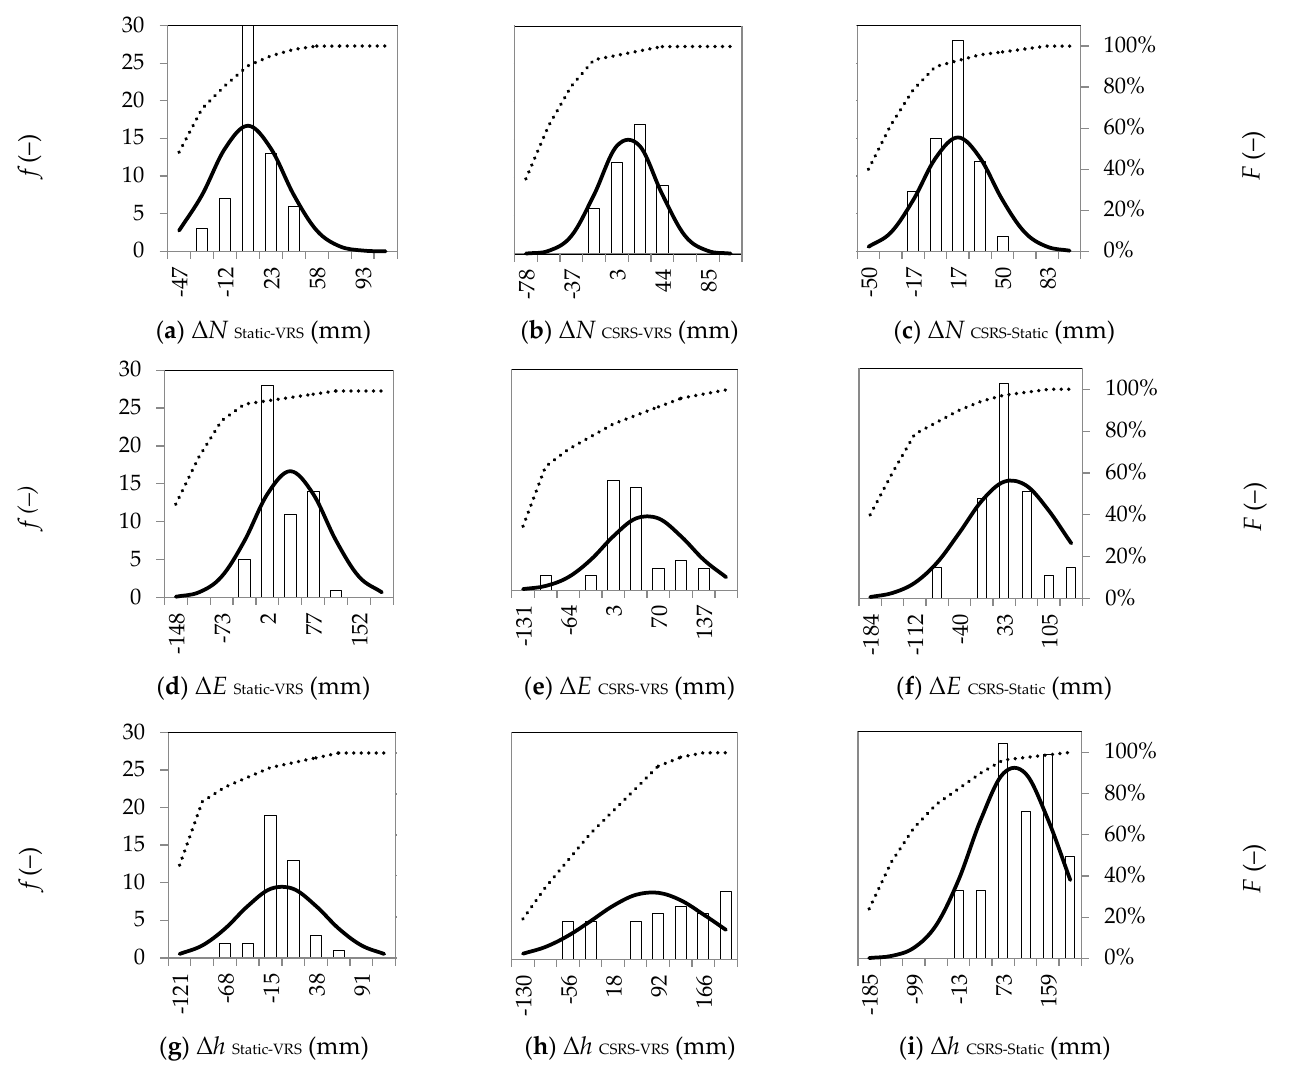
Figure 8. Empirical distribution frequency after extreme values removal (empty bars), best fitting normal distribution (black lines) and cumulative frequency of the empirical frequency before removing the extreme values (dashed line). Δ N, Δ E and Δ h differences (mm) are represented in the upper, central and lower graphs, respectively. Static vs. VRS, CSRS vs. VRS and CSRS vs. Static differences are represented in the left, central and right graphs, respectively, the minimum and maximum x -axis values change for the different pairs according to the corresponding range of variability: ( a ) Δ N Static-VRS (mm), ( b ) Δ N CSRS-VRS (mm), ( c ) Δ N CSRS-Static (mm), ( d ) Δ E Static-VRS (mm), ( e ) Δ E CSRS-VRS (mm), ( f ) Δ E CSRS-Static (mm), ( g ) Δ h Static-VRS (mm), ( h ) Δ h CSRS-VRS (mm), ( i ) Δ h CSRS-Static (mm)